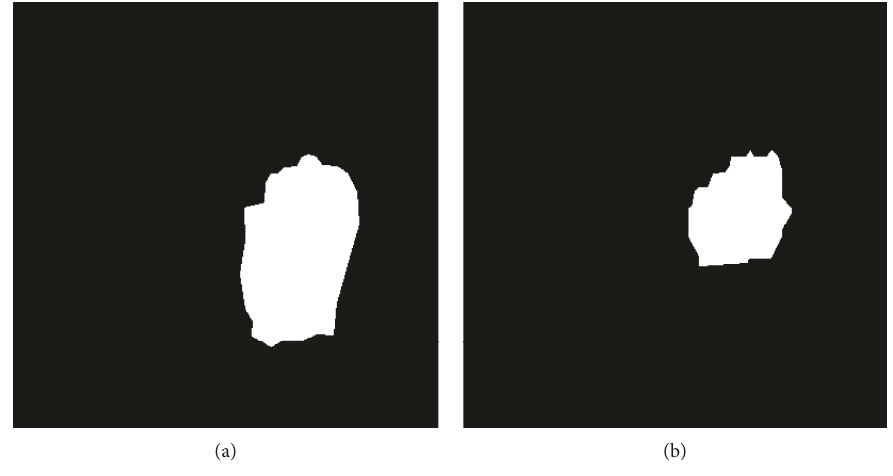
Figure 11: Similar segmented images: gestures S (a) and T